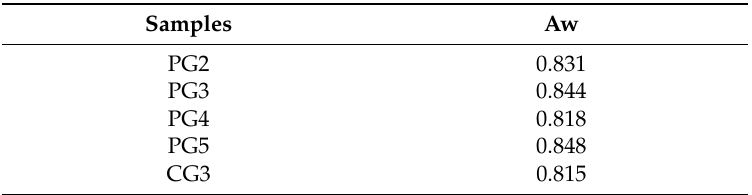
Table 3. List of analyzed samples and correlated water